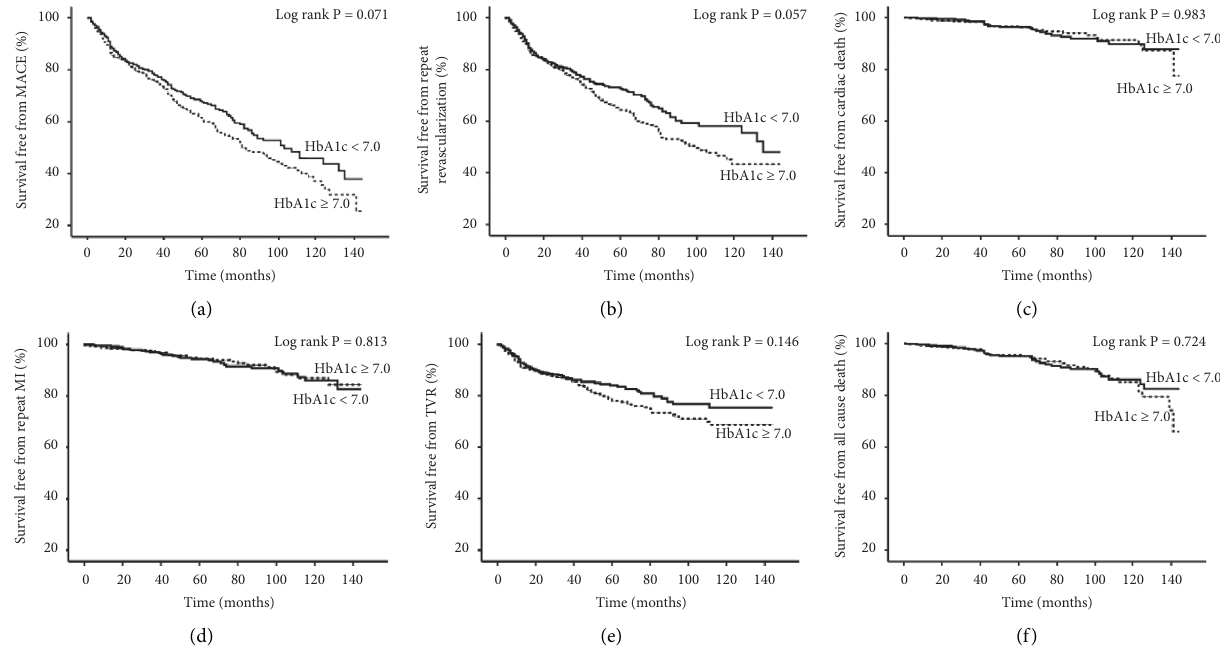
Figure 2: Kaplan–Meier cumulative event curves of MACE and secondary endpoints in the overall population. HbA1c: glycosylated hemoglobin A; MACE: major adverse cardiovascular events, which was a composite of cardiac death, repeat revascularization, and repeat nonfatal MI; TVR: target vessel revascularization; MI: myocardial